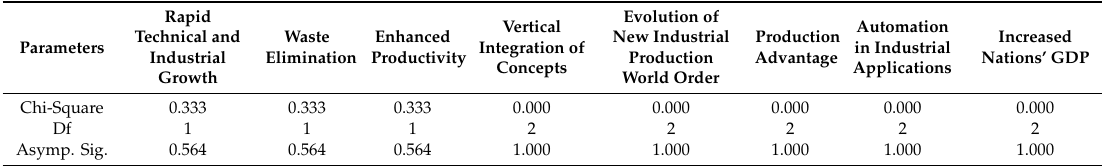
Table 19. Chi-square statistical test on Null and test hypothesis on performance expectation of project professionals of lean thinking and Industry